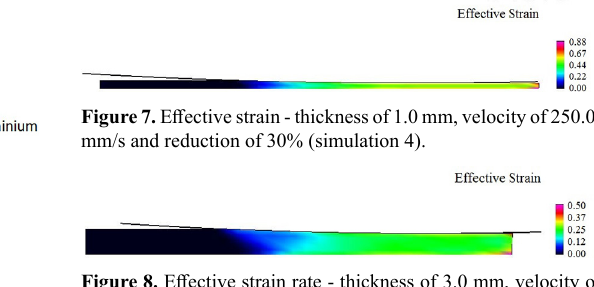
Figure 4. Flow stress curve used in simulations 5 and 6. value at the beginning of the contact between the steel and roll. As the material is processed, the value decreases along the interface of the sheet and roll. In the literature 6 , the region presenting a small value of the effective strain rate, below the interface of the sheet and roll, is called restricted flow zone. Inside this zone, the material presents a small deformation, causing an excessive pressure on the central material. The excessive pressure produces the high value of the effective strain rate at the central region in figures 5 and 6. Near the end of the sheet and roll contact region, the restricted flow zone disappears and the effective strain rate presents a small increase. The rate distribution in simulations 4 and 5 is similar to that observed by LIN and SHEN 27 and KOMORI 28 .